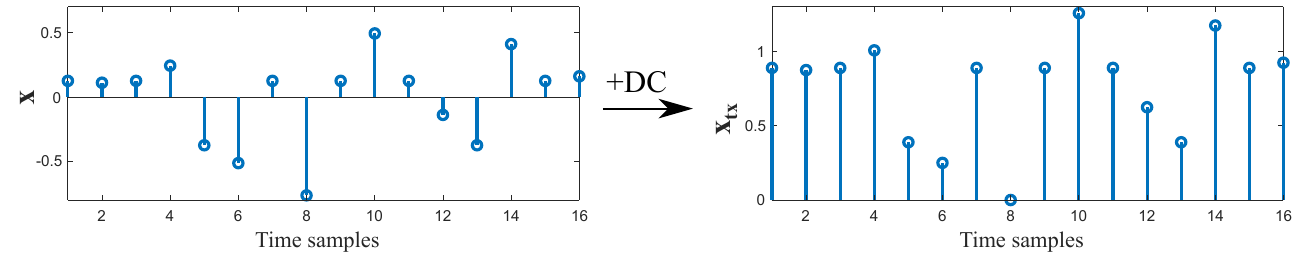
Figure 6. Time-domain DCO-OFDM signal.